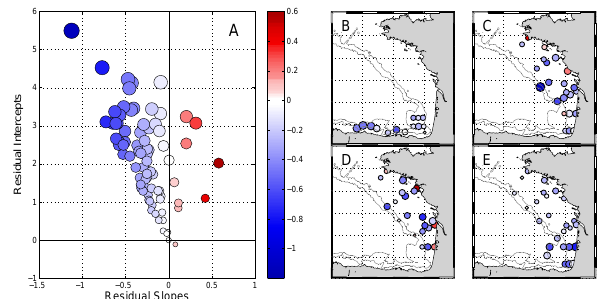
Figure 3. Size structure characteristics of residuals between NBSS estimated by the LOPC and by the WP2/Zs procedure. The color map indicates the value of the slope of the residuals (blue for nega- tive slope, red for positive ones and white for null slopes). The size of points indicates the value of the intercept of residuals (the bigger the points, the larger the intercepts). (a) shows the relation between the slope and the intercept of residuals. (b – e) show the spatial dis- tribution of residuals for the four cruises in which data are available for both LOPC and WP2/Zs ( b : PELACUS 2007, c : PELGAS 2009, d : PELGAS 2010 and e : PELGAS 2011) using the same color map but size of points being divided by three for